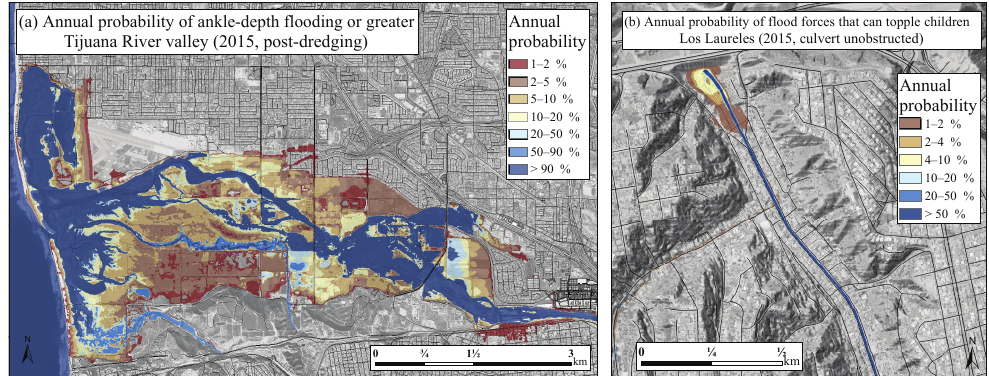
Figure 5. (a) Annual exceedance probability (AEP) of ankle-depth flooding in the Tijuana River valley. Contours represent the annual probability that either storm tides, canyon flows, or Tijuana River discharges can cause flooding that exceeds ankle depth. (b) AEP of flood forces that can topple children in Los Laureles. Here, contours represent the annual probability that streamflow will be intense enough to topple children. The ankle-depth threshold was defined as 0.11m, and the children toppled threshold was defined as 0.4m 2 s − 1